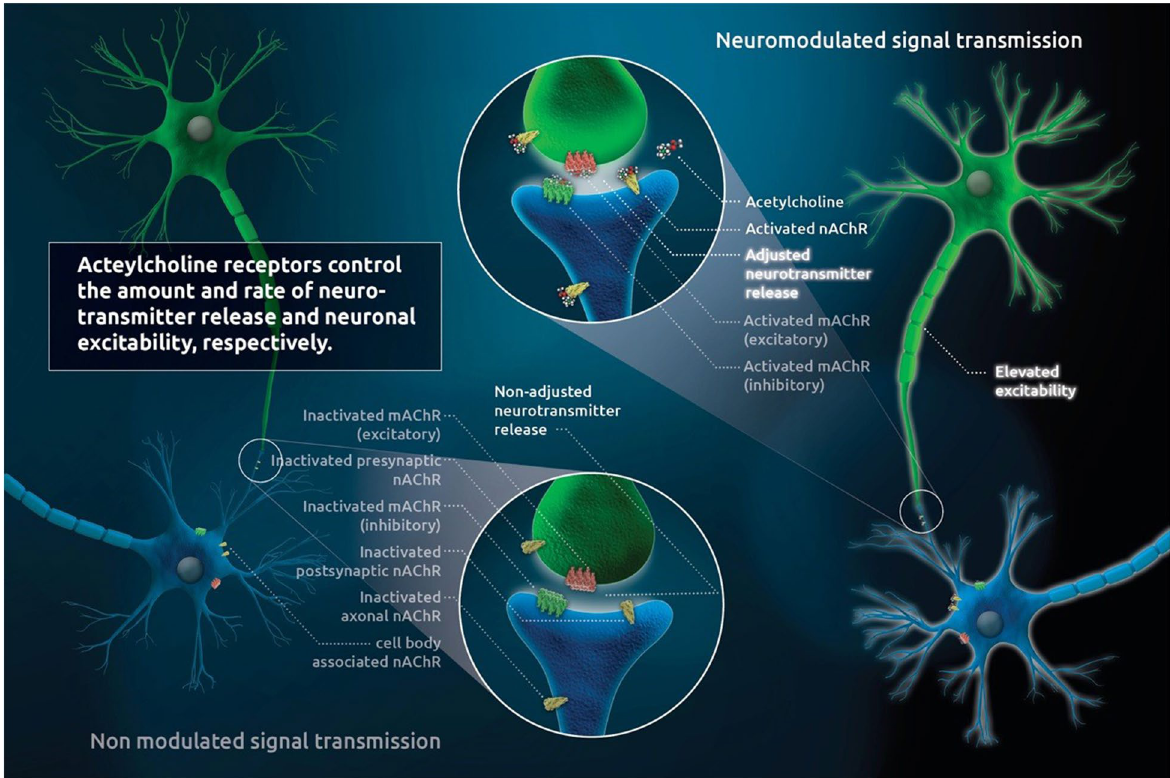
Fig. 1 (Cholinergic neuromodulation): AChRs are located in the membranes of neural cell bodies, as well as in pre- or post-synaptic sites and at the axonal membranes. ACh binding regulates both the velocity and amount of transmitter release, as well as cell excitability; it also orchestrates network operation between several core groups, as well as synchronized response behavior to internal and external stimulation. Cholinergic neuro-modulatory action is an indispensable requirement for neural plasticity, neuronal development and learning processes. Thus, numerous physiological functions (sleep, arousal, fatigue, anxiety, nutritional behavior, cognition and central processing of pain) are interactively regulated by cholinergic neuromodulation. The two different subtypes of AChRs bind, despite ACh, to either nicotine (nAChrs) or muscarine (mAChRs). While mAChRs act slowly and promote a multitude of excitatory or inhibitory transmission effects via numerous canonical and non-canonical pathways, nAChRs consist of a homomeric (α) or heteromeric (α/β) configuration of 5 subunits, forming calcium channels with fast reaction to agonistic stimulation. These allosteric nAChRs are the principal structures of central and autonomic neuromodulation and underlie great plasticity in terms of count, binding sites and affinity dependent upon agonist